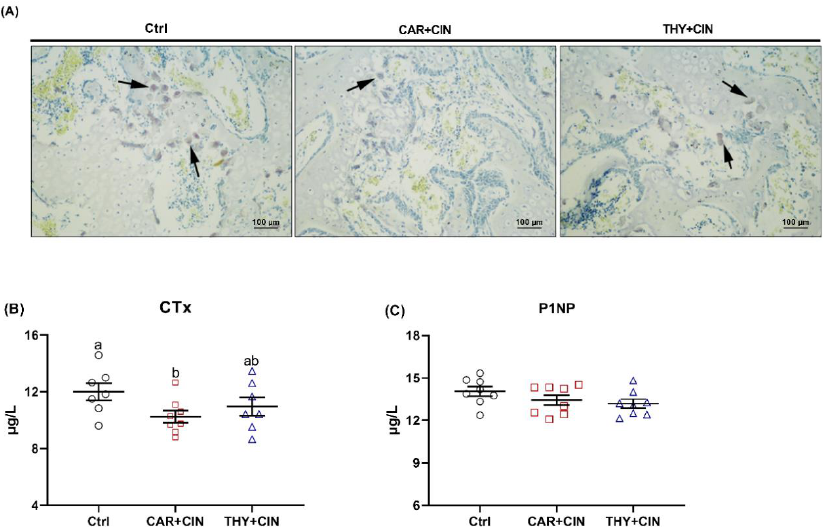
Figure 6. Impacts of the combination of cinnamaldehyde with carvacrol (CAR+CIN) or thymol (THY+CIN) on bone turnover of laying hens: ( A ) tartrate-resistant acid phosphatase (TRAP) staining of tibia sections, ( B ) bone resorption biomarker C-terminal cross-linked telopeptide of type I collagen (CTx) content, and ( C ) bone formation biomarker Procollagen type I intact N-terminal propeptide (P1NP) concentration were determined. Values are mean ± standard error (SE) represented by vertical bars ( n = 7 – 8). a,b Values without common superscript are notably different ( p < 0.05).